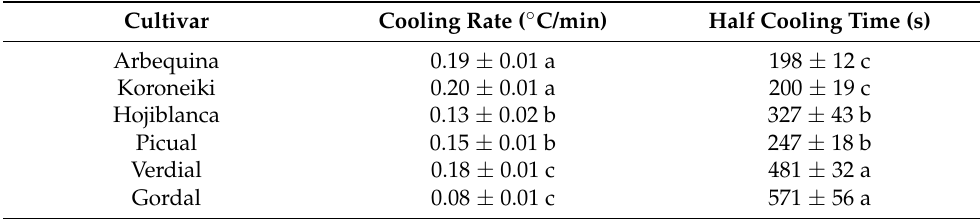
Values are mean and SD. For each variable, values followed by different letters are significantly different according to the post-hoc Tamhane test ( p <